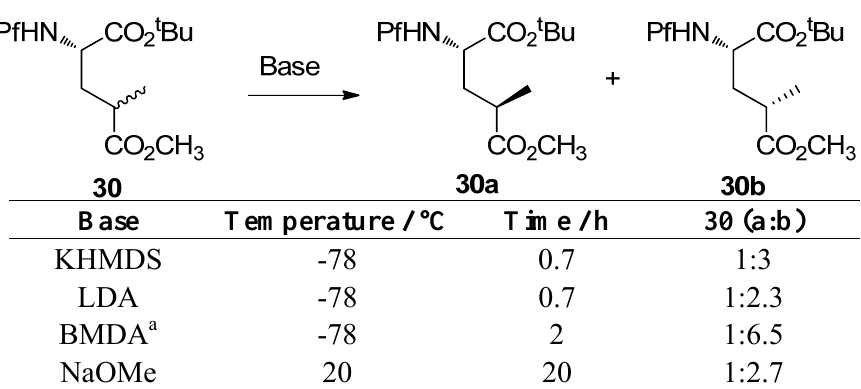
Table 4. Epimerization of γ -methyl glutamate.